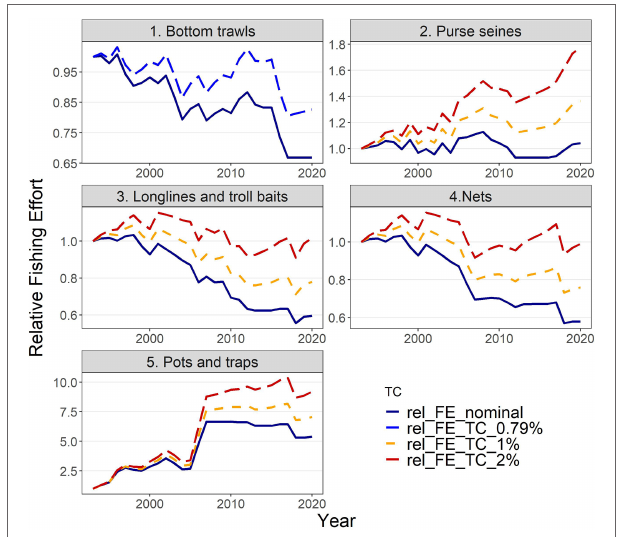
FIGURE 2 | Relative fishing effort (rel_FE; in total GT) used to drive the model under different factors of technology creep (TC): (i) no technology creep (nominal), (ii) 0.79% annually only for bottom trawls, based on Damalas et al. (2014), (iii) 1% annually and (iv) 2% annually for the remaining fishing fleets.